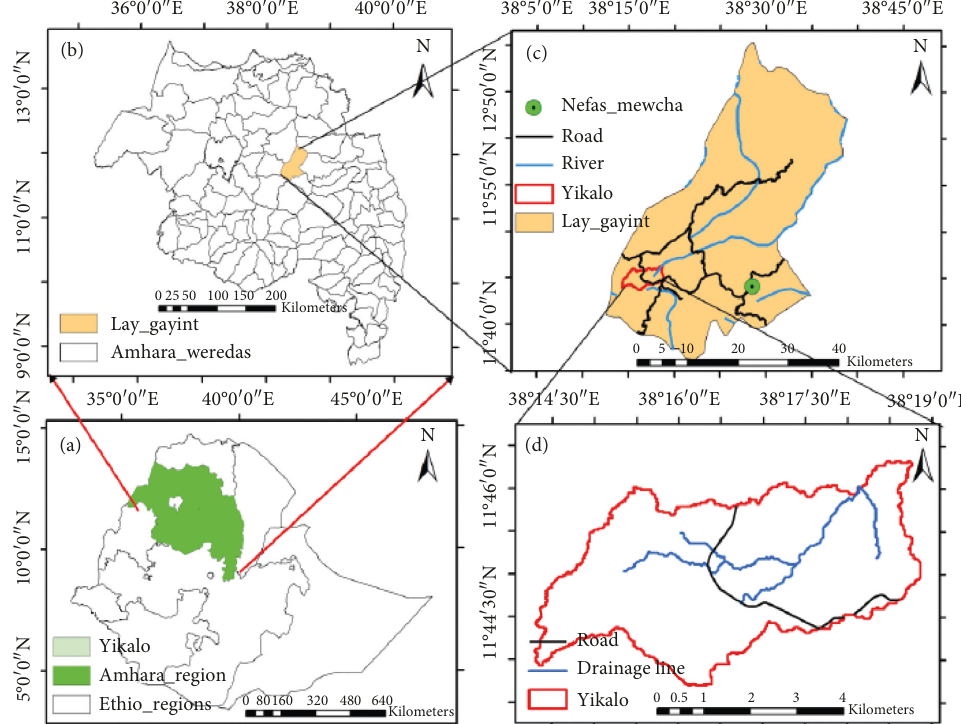
Figure 1: Location map of the study area. (a) Amhara National Regional State in Ethiopia (ANRS), (b) Lay Gayint district in ANRS, (c) study area, and (d) drainage